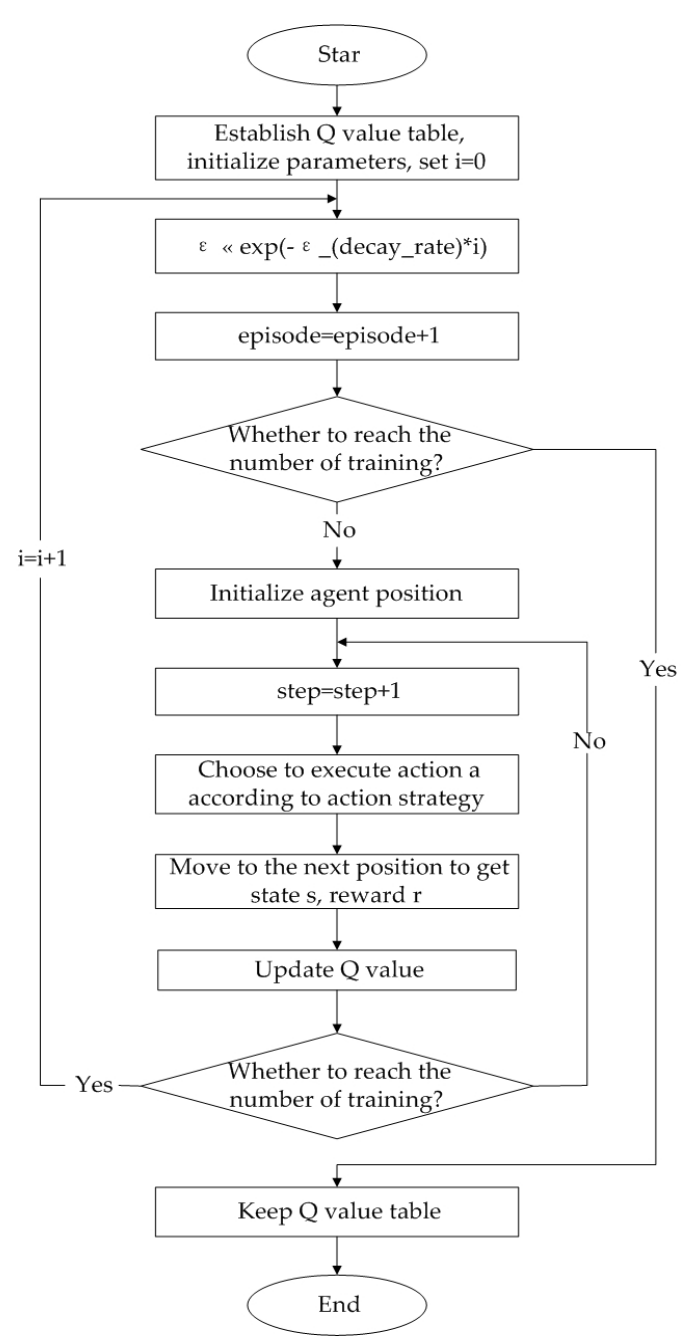
Figure 3. Flow chart of the Q - learning optimization algorithm in the grid environment.